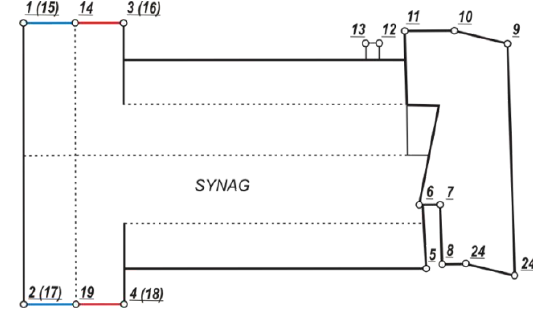
Figure 3. Diagram of the SYNAG structure with characteristic points (roof peaks) numbered according to the adopted